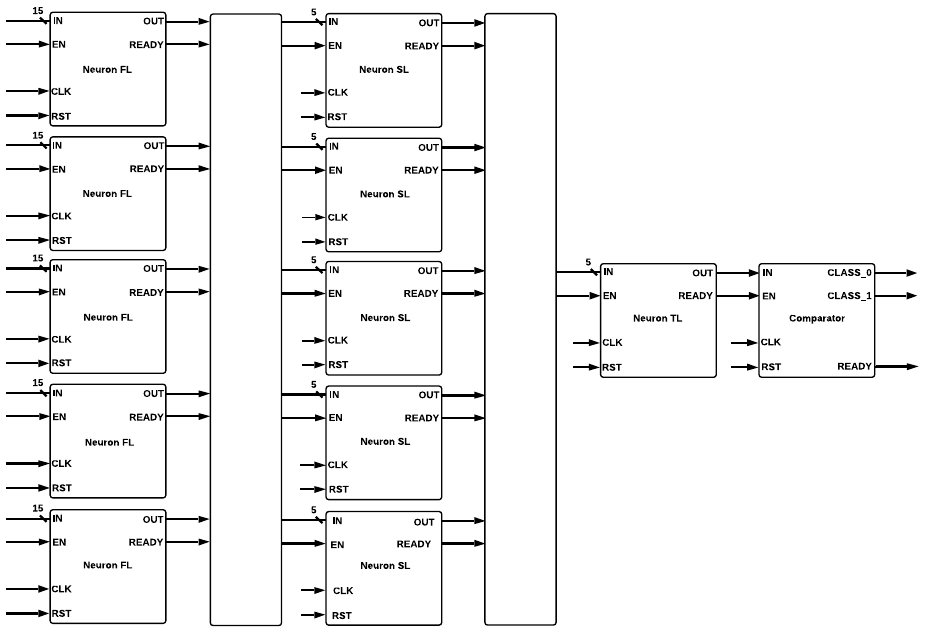
Figure 8. Neural Network Hardware Architecture.